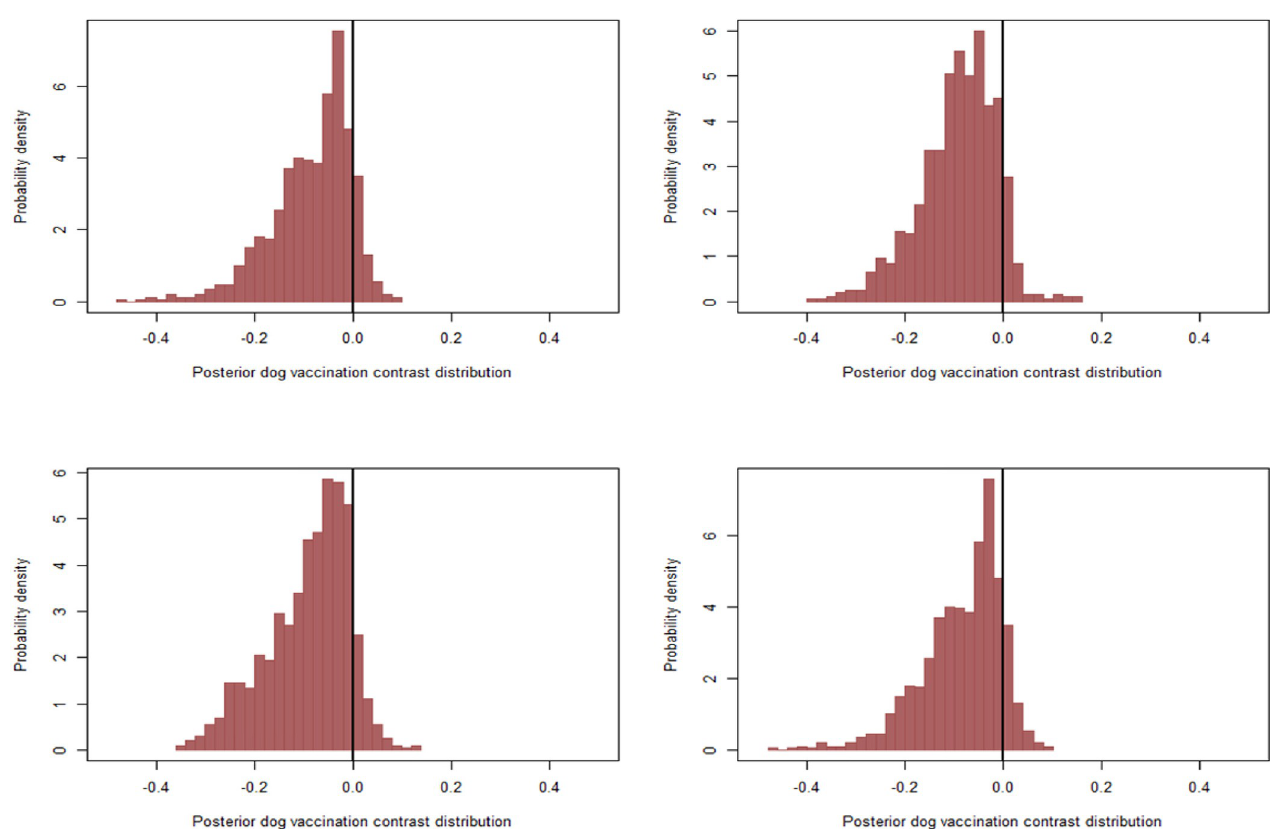
Fig 5. Posterior marginal contrast distribution demonstrating how the estimated probability of deaths was predicted to change when comparing bites from vaccinated to unvaccinated dogs, when the vaccination probability was adjusted to 35% to account for 3% of free-roaming dogs (Top left) when the probability of vaccination was varied between 20% and 45% in each MCMC iteration(Top right) when the probability for owned and free-roaming dogs were varied between 35% and 60% for owned dogs and 30% for free-roaming dogs(Button left) and we varied the probabilities between 25% - 75% for owned and 20%- 45% for free-roaming dogs(Button